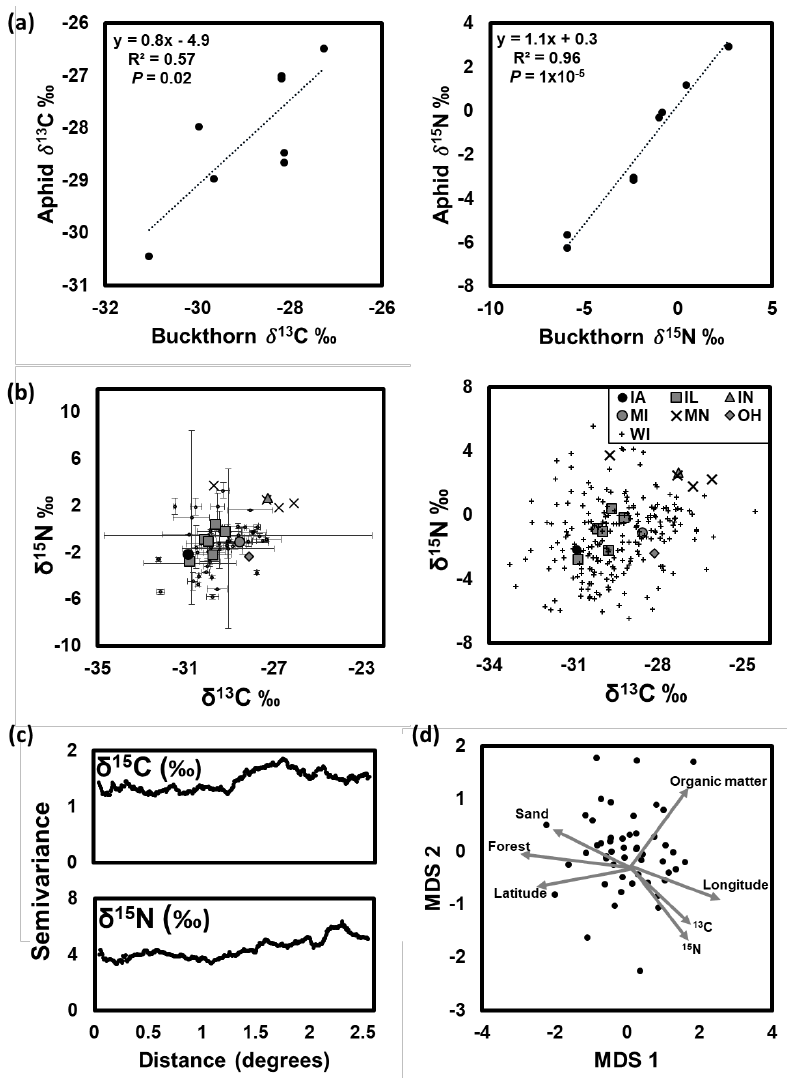
Figure 2. ( a ) Linear regressions of soybean aphid on buckthorn host plant δ 13 C and δ 15 N (‰; N = 11). A slope = 1 indicates perfect congruence between aphid and host plant, while a slope greater or less than 1 indicates enrichment or depletion, respectively, of the aphid relative to its host plant. ( b ) Comparison of individual (right) and mean ± standard deviation (left) δ 13 C and δ 15 N (‰) values of buckthorn plants. ( c ) Semivariograms depicting no spatial autocorrelation in δ 13 C and δ 15 N (‰) values among buckthorn plants in the Midwest at the scales sampled. ( d ) Non-metric multidimensional scaling plot depicting variability among buckthorn sample sites in terms of δ 13 C and δ 15 N (‰), and along environmental gradients in percent sand and organic matter content, percent forest, longitude and latitude. Stress was 0.21. The linear and non-metric fit (R 2 ) between observed dissimilarity and ordination distance was 0.82 and 0.96, respectively.